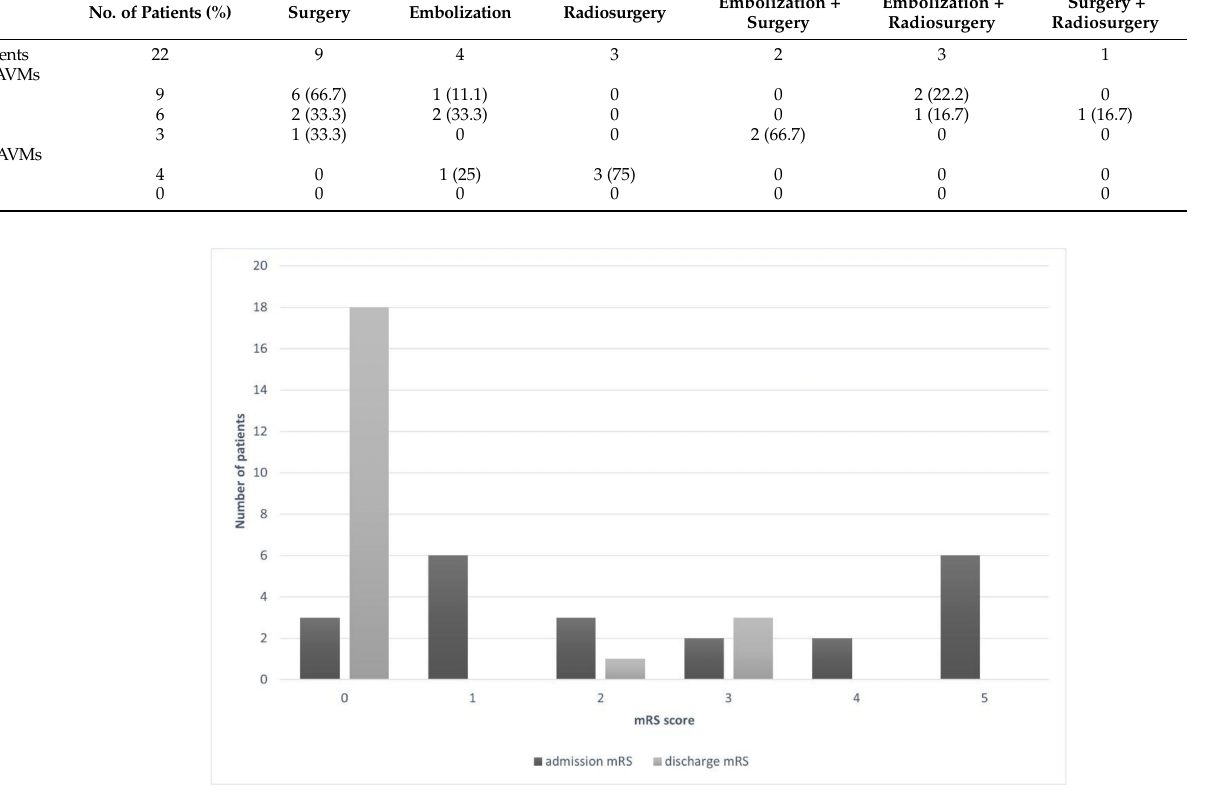
Figure 1. Relationship between mRS scores at admission and discharge from the hospital.